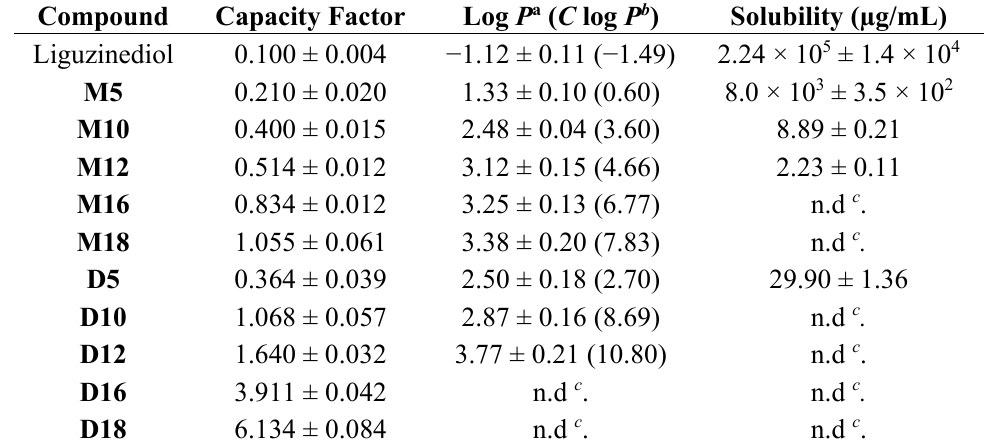
Table 2. Capacity factor, Apparent Partition Coefficient and Aqueous Solubility ( n = 3; mean ± SD).